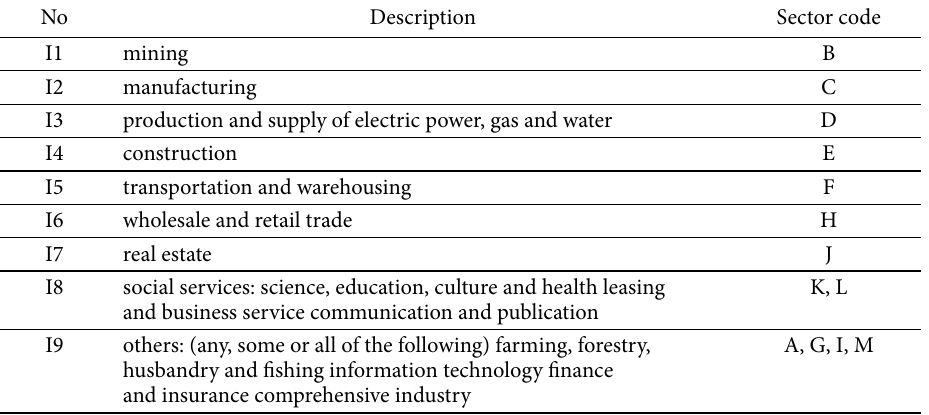
Table 3. adjusted sector classification